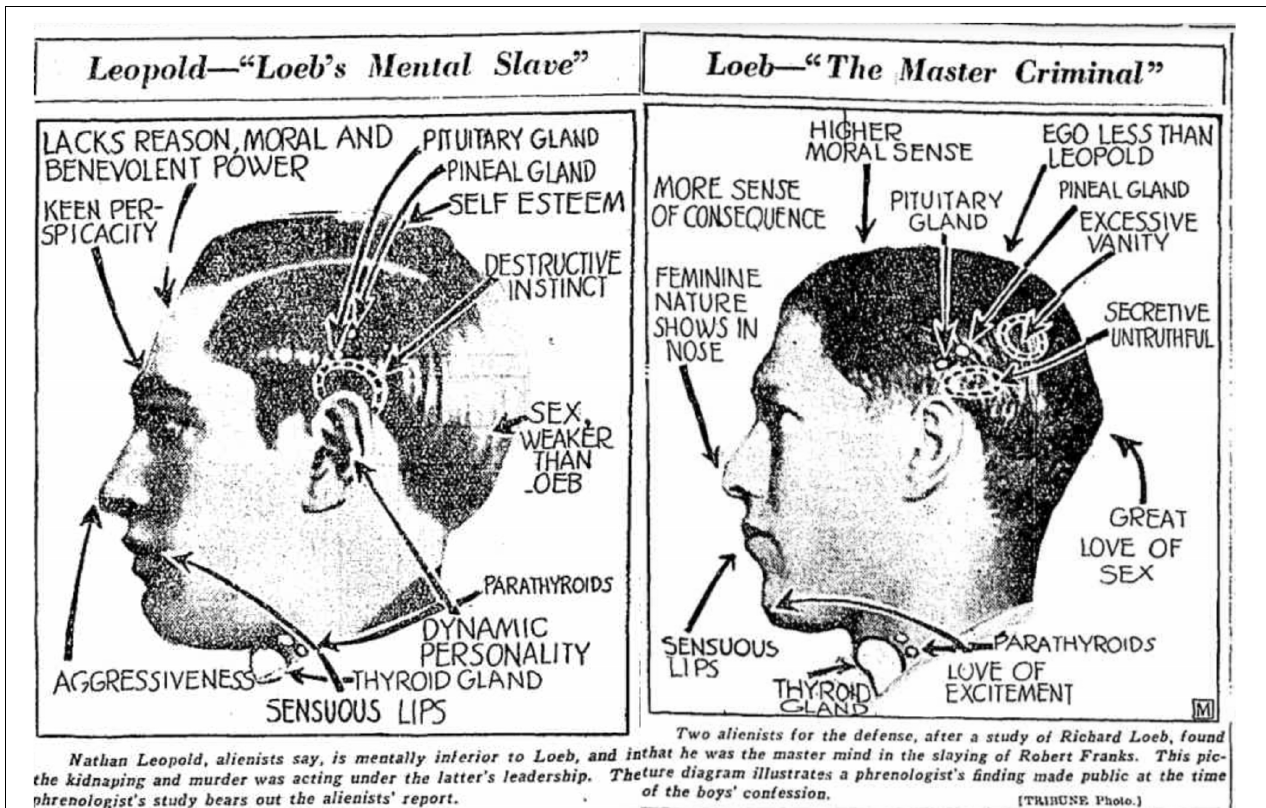
FIGURE 5 | Psychiatrists’ (“alienists”) phrenological assessments of Mr. Nathan Leopold and Mr. Richard Loeb as they appeared in The Chicago Tribune in the summer of